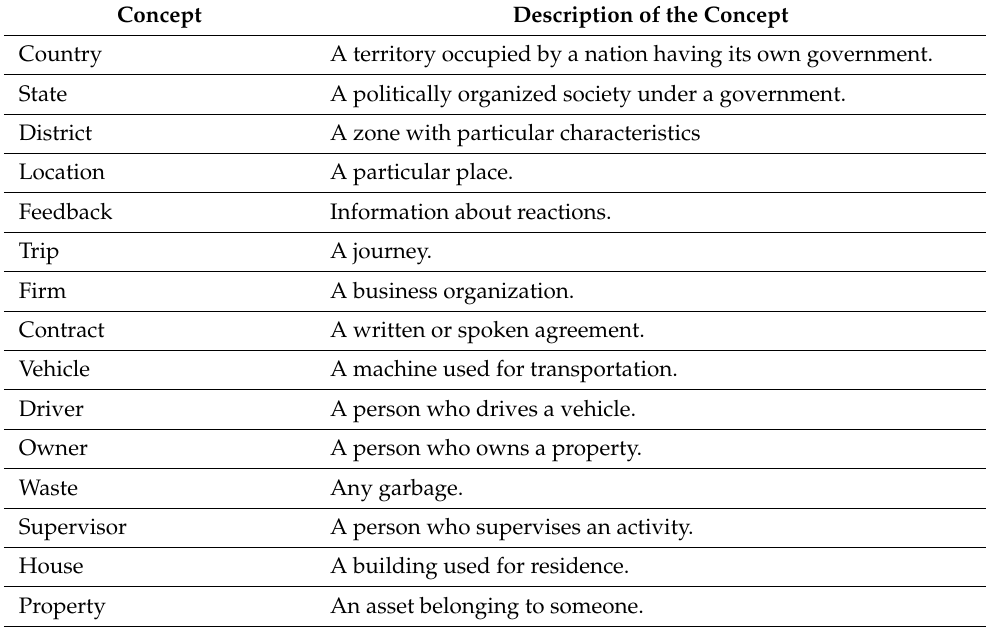
Table 3. A sample glossary containing some general concepts.